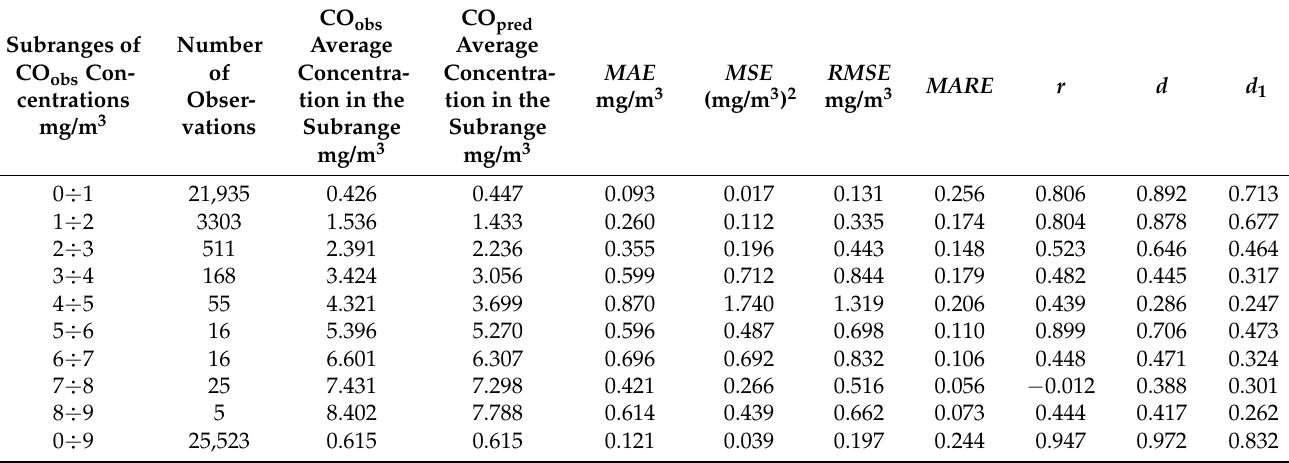
Table 7. Values of approximation errors calculated for different subranges and the entire range of CO obs concentrations (hourly data, Zabrze 2011–2016), CO obs means real CO concentration, and CO pred means predicted CO